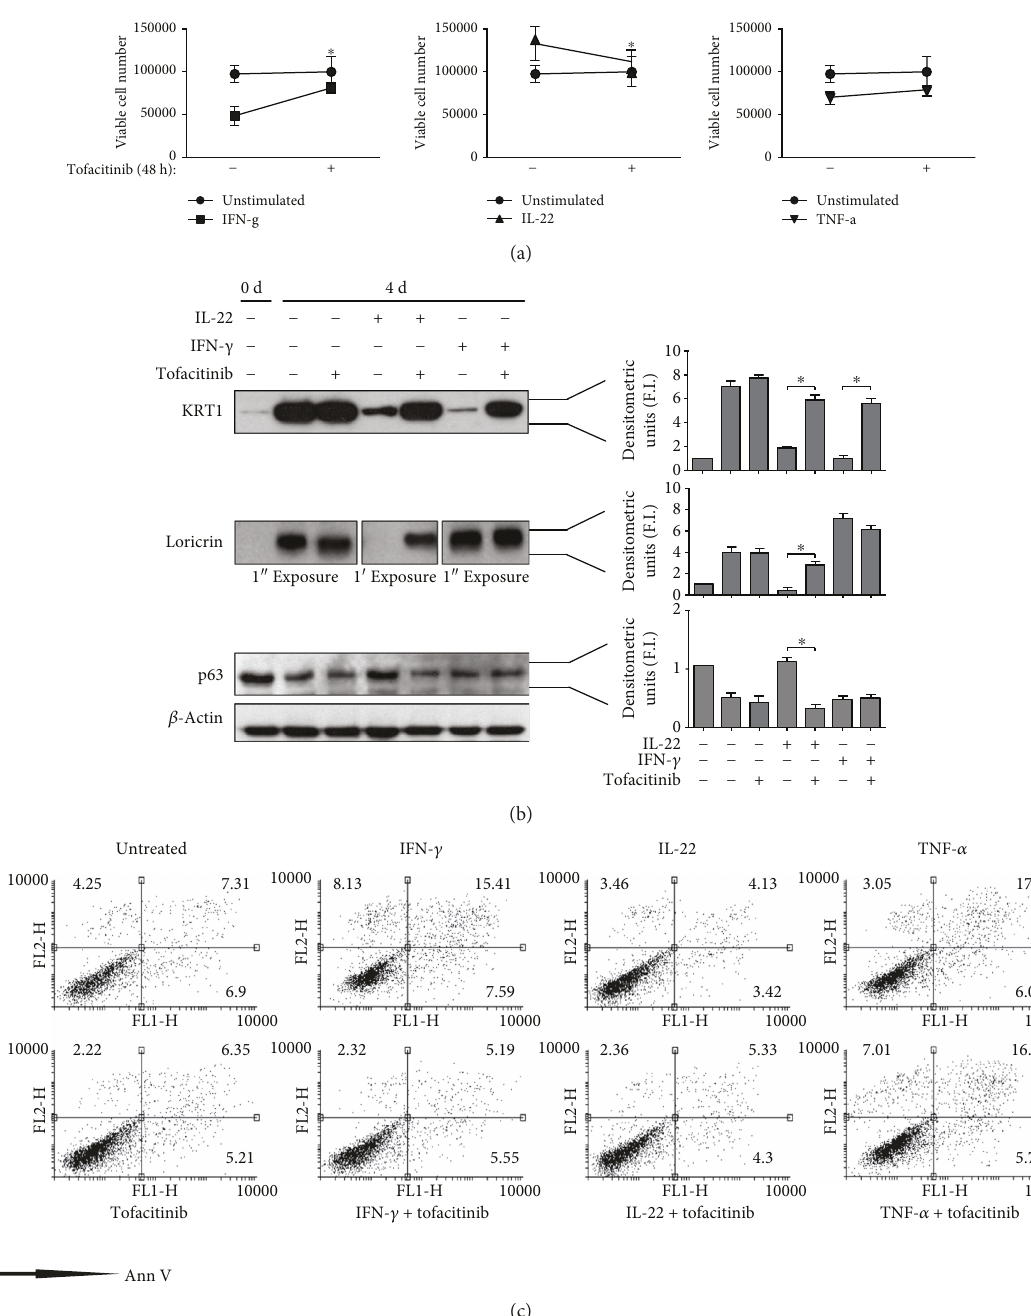
Figure 3: Tofacitinib regulates proliferation, di ff erentiation, and apoptosis of IFN- γ - and IL-22- but not TNF- α -treated keratinocytes. Proliferation of keratinocyte cultures untreated or treated with 5 μ M tofacitinib, either in the presence or absence of IFN- γ , IL-22, or TNF- α , was analysed by Trypan blue exclusion test (a), which was performed after 48h of culture. Data are expressed as total cell number ± SD. ∗ p < 0 05 . (b) Keratin 1 (KRT1), loricrin, and p63 were analysed by WB by using protein lysates obtained from keratinocyte cultures grown at 100% con fl uency (0 d) or for additional four days (4 d), in the presence or absence of tofacitinib and IFN- γ or IL-22. Graphs show densitometric values ± SD of KRT1, loricrin, or p63. Data are expressed as densitometric units, expressed as fold induction (F.I.) of treated vs. untreated samples, which were given a value of 1. ∗ p < 0 01 . (c) Apoptosis of cultured keratinocytes treated with 5 μ M tofacitinib in the presence or absence of IFN- γ , IL-22, or the proapoptotic stimulus TNF- α for 48h was examined by measuring Annexin (Ann V)/propidium iodide (PI) fl uorescence through fl ow cyto fl uorimetry. A representative experiment of three performed with two di ff erent psoriatic keratinocyte strains is shown, with numbers indicating the percentage of PI + (upper left), Ann V + (lower right), PI/Ann V + (upper right), or negative (lower left)